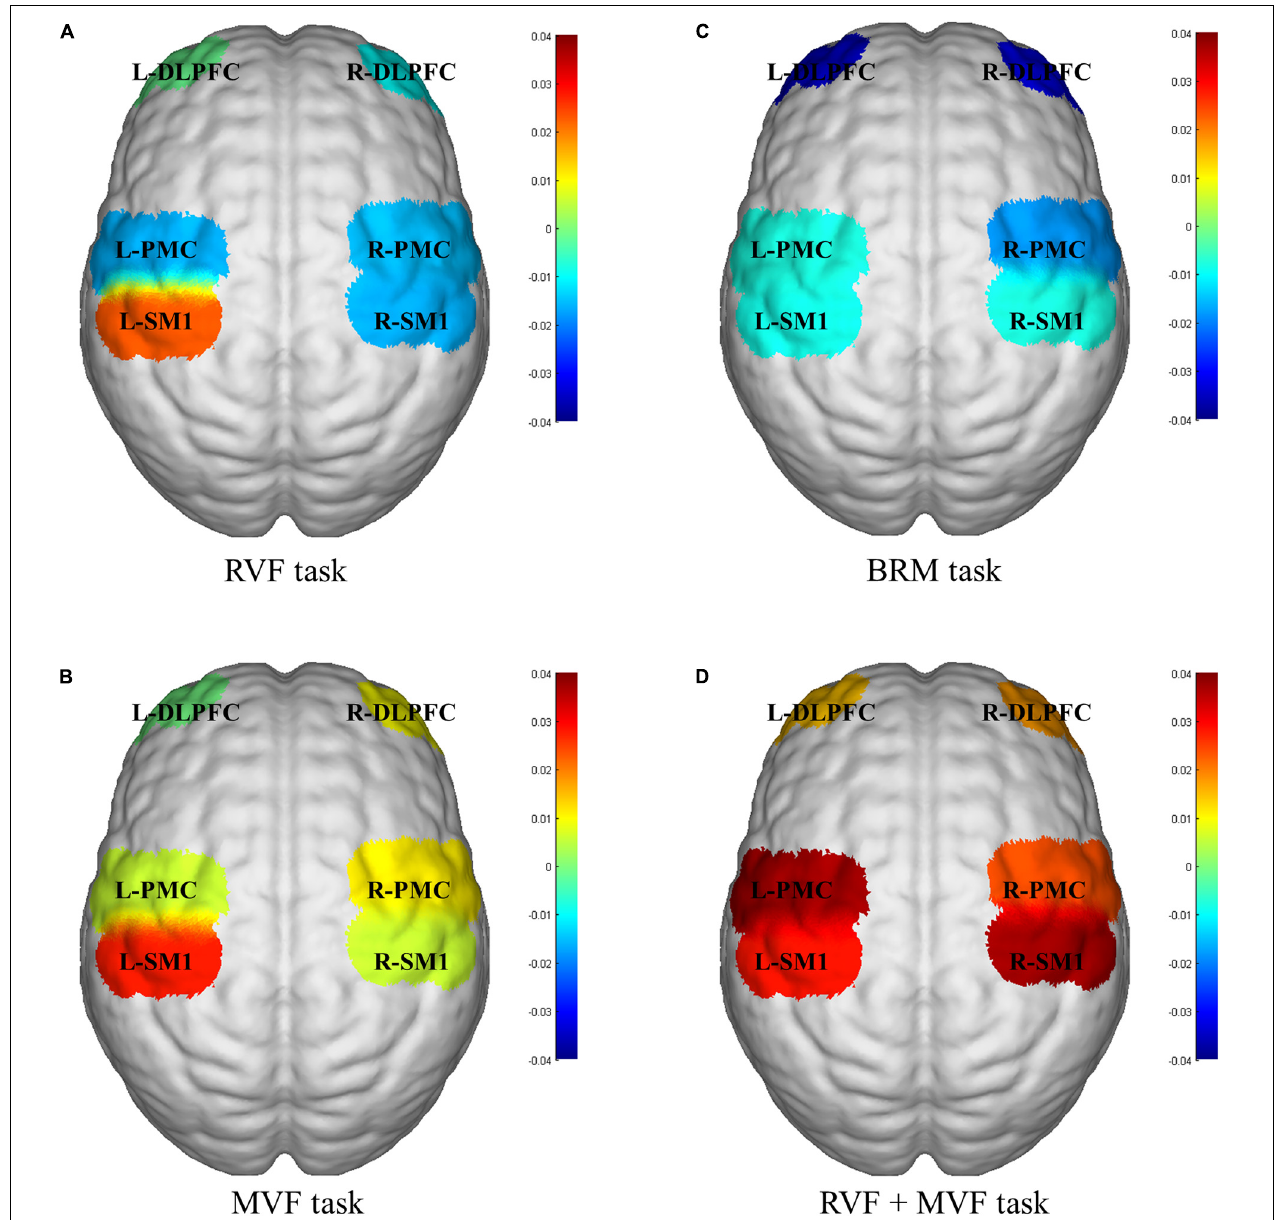
FIGURE 5 | fNIRS activation maps for four visual feedback tasks. (A) RVF task; (B) MVF task; (C) BRM task; (D) RVF+MVF task. The beta values are indicated by color. RVF task, real visual feedback task; MVF task, mirror visual feedback task; BRM task, bilateral robotic movement task; MVF + BRM task, Mirror visual feedback combined with bilateral robotic movement task; SM1, primary sensorimotor cortex; PMC, pre-motor cortex; DLPFC, dorsolateral prefrontal cortex; L, left; R,